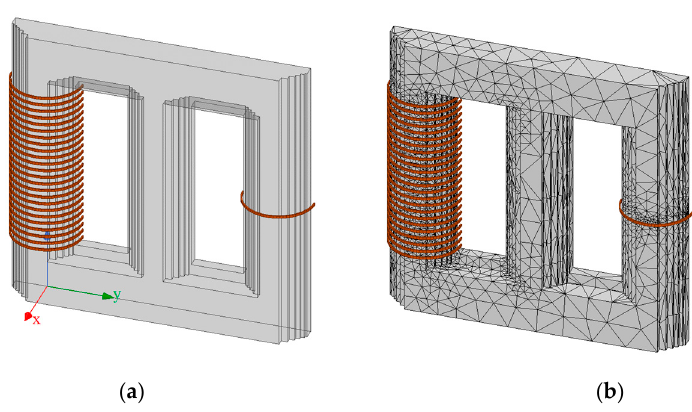
Figure 4. Three-dimensional (3D) model ( a ) and its discretization into finite element mesh ( b ).